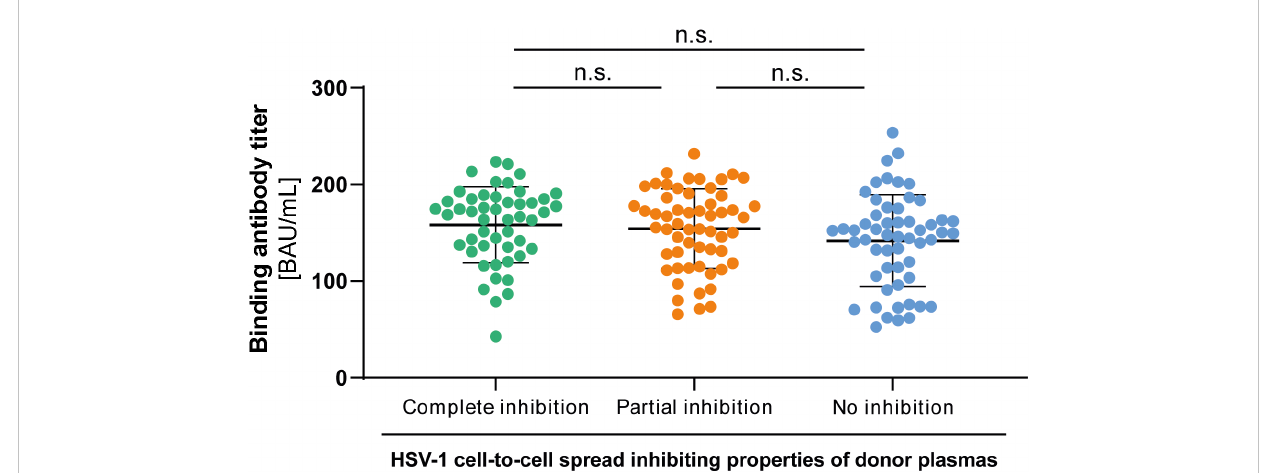
FIGURE 5 HSV-1 speci fi c binding IgG antibody titers to HSV-1. HSV-1 speci fi c binding antibody titers of 158 HSV-1 plasmas from blood donors that participated the retrospective survey regarding HSV-reactivations were determined by an Anti-HSV-1-IgG ELISA. The median optical density (OD450) was measured and binding antibody titers were calculated from the standard curve. Data sets were statistically analyzed using the One-way ANOVA followed by the Dunn ’ s multiple comparison post-hoc test. Non-signi fi cant changes (p > 0.05) are labeled as “ n.s. ”